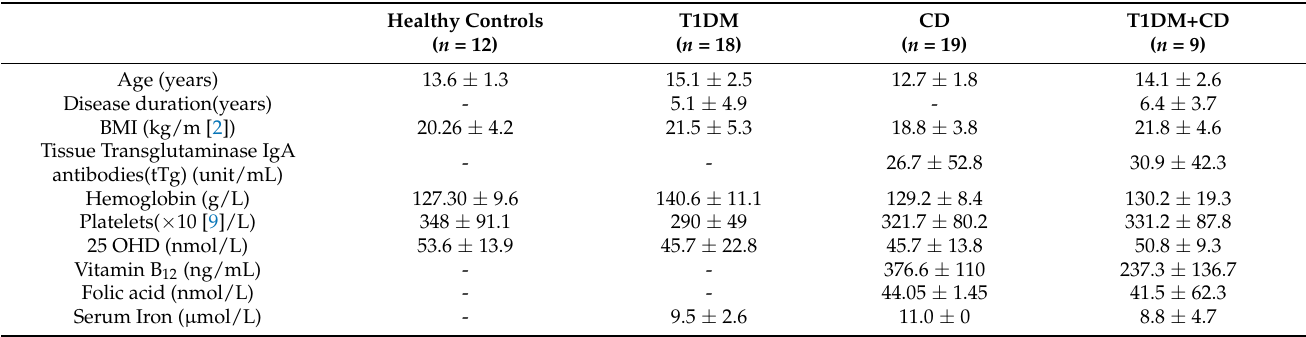
Table 1. Basic and clinical demographics in control subjects, CD, T1DM, T1DM+CD